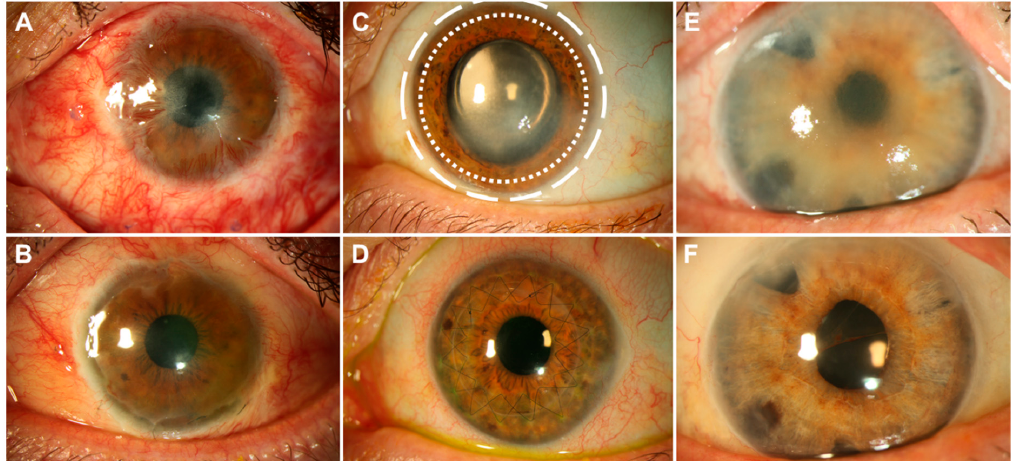
Figure 1. Bioarchitecture of the human cornea. Schematic illustration of ( A ) the cross-section of the human eye ball, ( B ) cornea, and ( C ) histological section of a human cornea showing the ultrastructure of the three main layers (epithelium, stroma, and endothelium) as well as the Bowman’s layer and the Descemet’s membrane (courtesy of Matthias Fuest, MD, RWTH Aachen University). ( D ) Illustration of orthogonally aligned collagen lamellae present in the human corneal stroma.